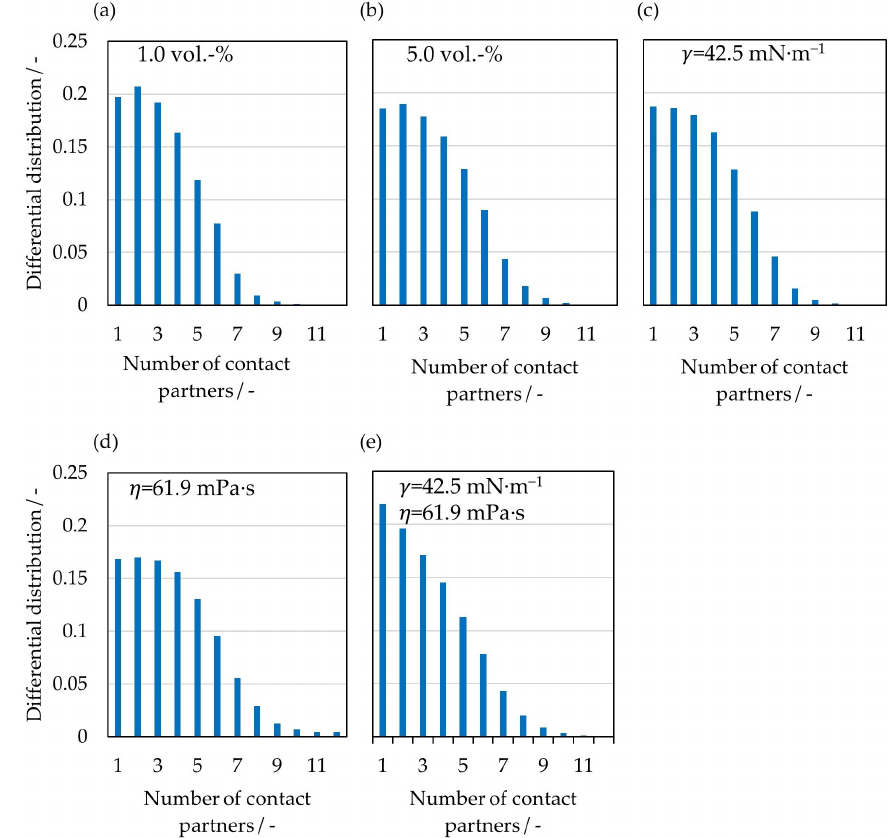
Figure 8. Differential distribution of the number of simultaneous contact partners for a ( a ) liquid loading of 1 vol.-%, ( b ) liquid loading of 5 vol.-%, ( c ) surface tension of 42.5 mN∙m −1 , ( d ) viscosity of 61.9 mPa∙s, and ( e ) surface tension of 42.5 mN∙m −1 and viscosity of 61.9 mPa∙s. In Figure 9, the differential distribution of the time-averaged contact velocities can be seen. For this purpose, the contact velocities were counted in intervals of 0.01 m∙s −1 and divided by the total number of contacts. Since the distribution of the contact velocities is wide, the velocity range is shown up to 0.2 m∙s −1 for clearer visualization. In addition, the shown range represents 98% of the occurring impact velocities. As expected, the signifi- cantly higher viscosity in the last two cases (d) and (e) leads to an increase in the propor- tion of low contact velocities of less than 0.05 m∙s −1 , while the proportion of higher contact velocities decreases accordingly. The reason is the stronger viscous forces, which always oppose the motion of the particles and thus slow them down in the approach phase during contact. This can also be confirmed by the capillary number, which, in these cases, is in the range of 10 − 2 , whereas in the other cases (a)–(c), it is in the range of 10 −4 . The re-